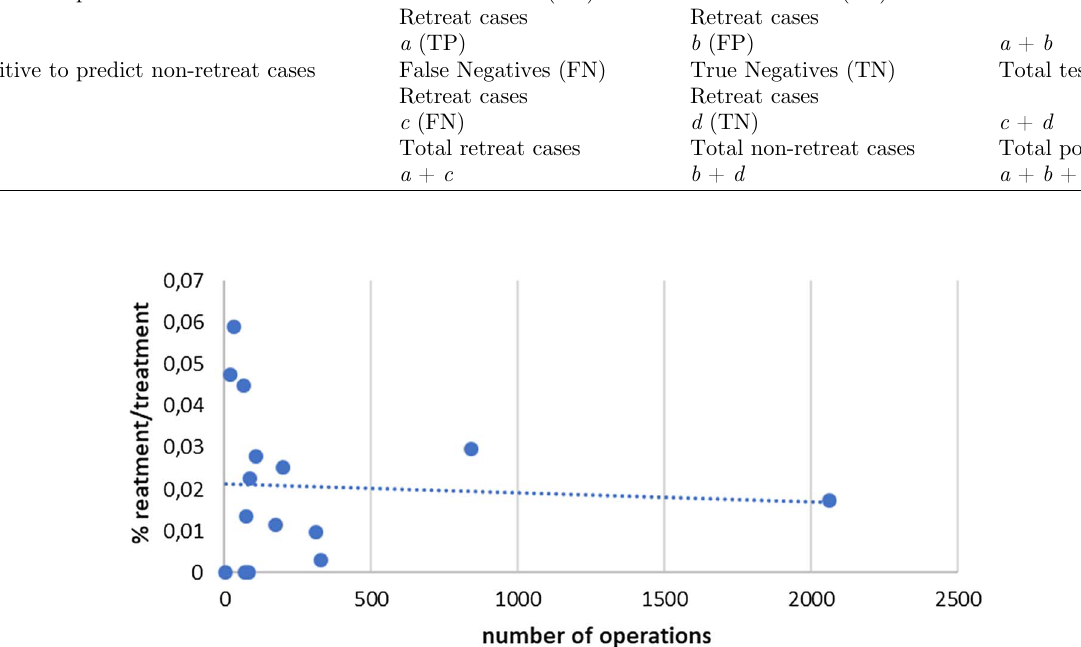
Figure 2. Individual performance of Ophthalmica surgeons regarding their retreatments/treatment ratios, r = (cid:3)